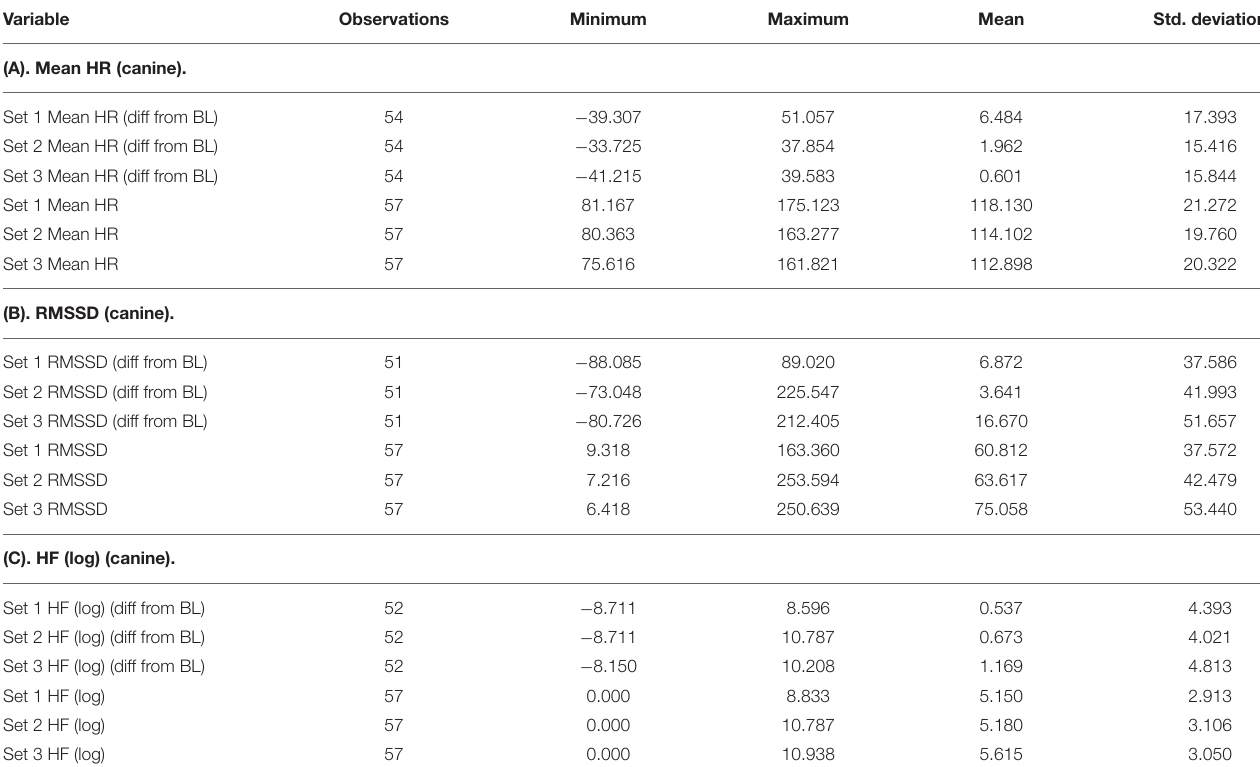
TABLE 3 | Descriptive statistics for the canine cardiac activity parameters (raw data, and difference from baseline, BL), by handling set#: ( A) mean HR, (B) RMSSD, (C) HF (log). Variable Observations Minimum Maximum Mean Std.